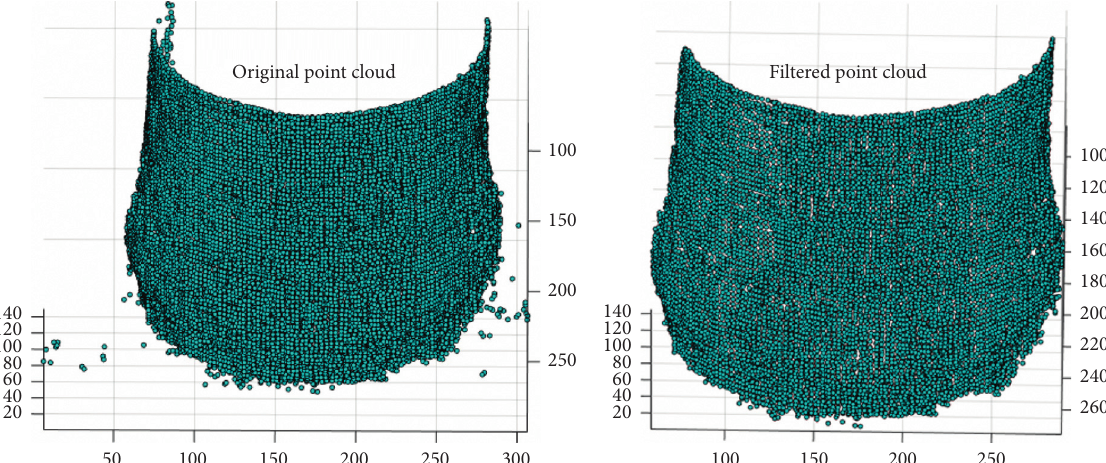
Figure 8: Original and filtered point cloud.